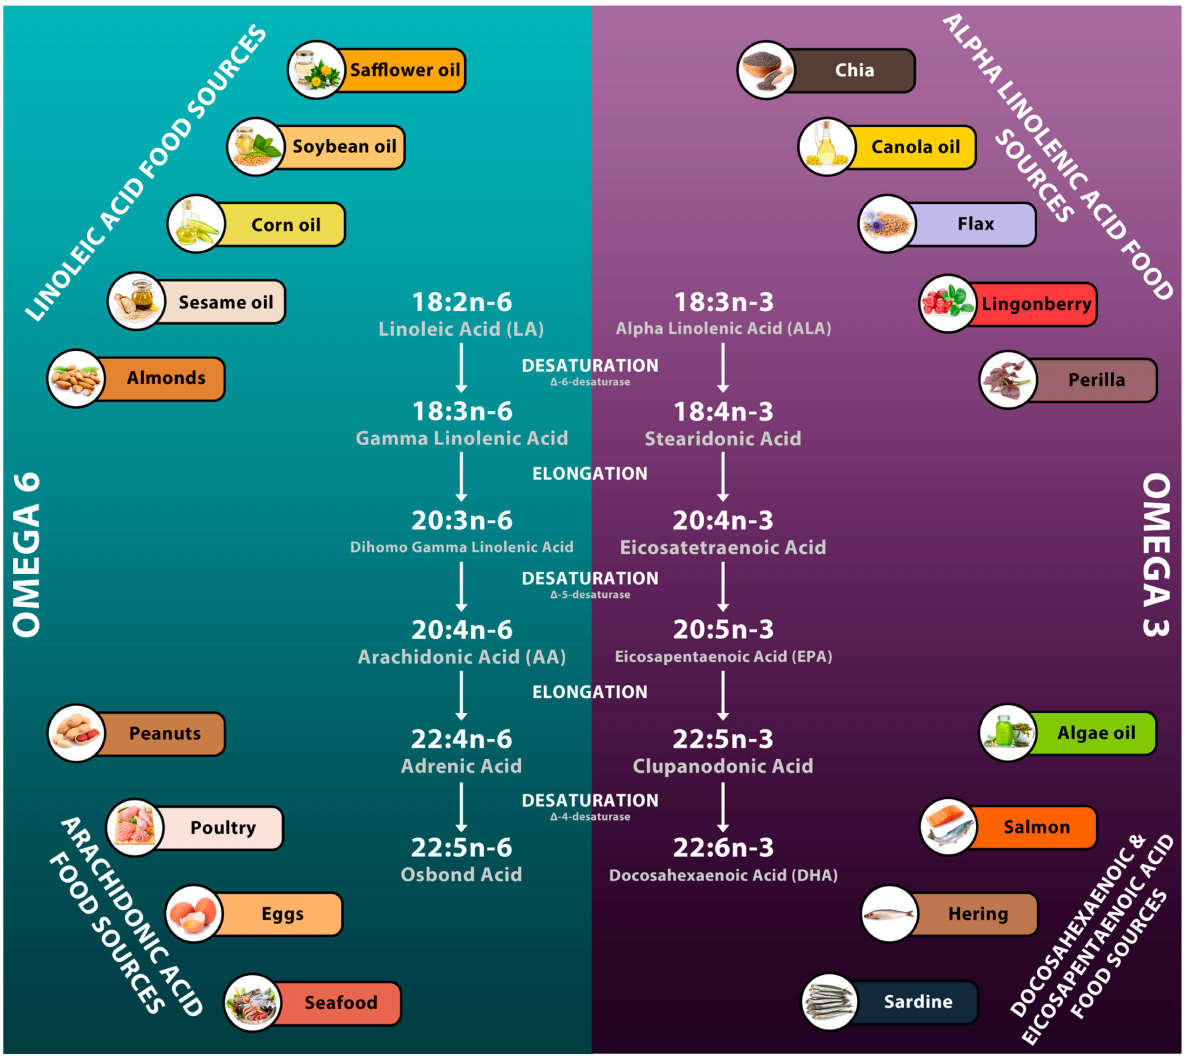
Figure 2. Omega-3 and Omega-6—sources and